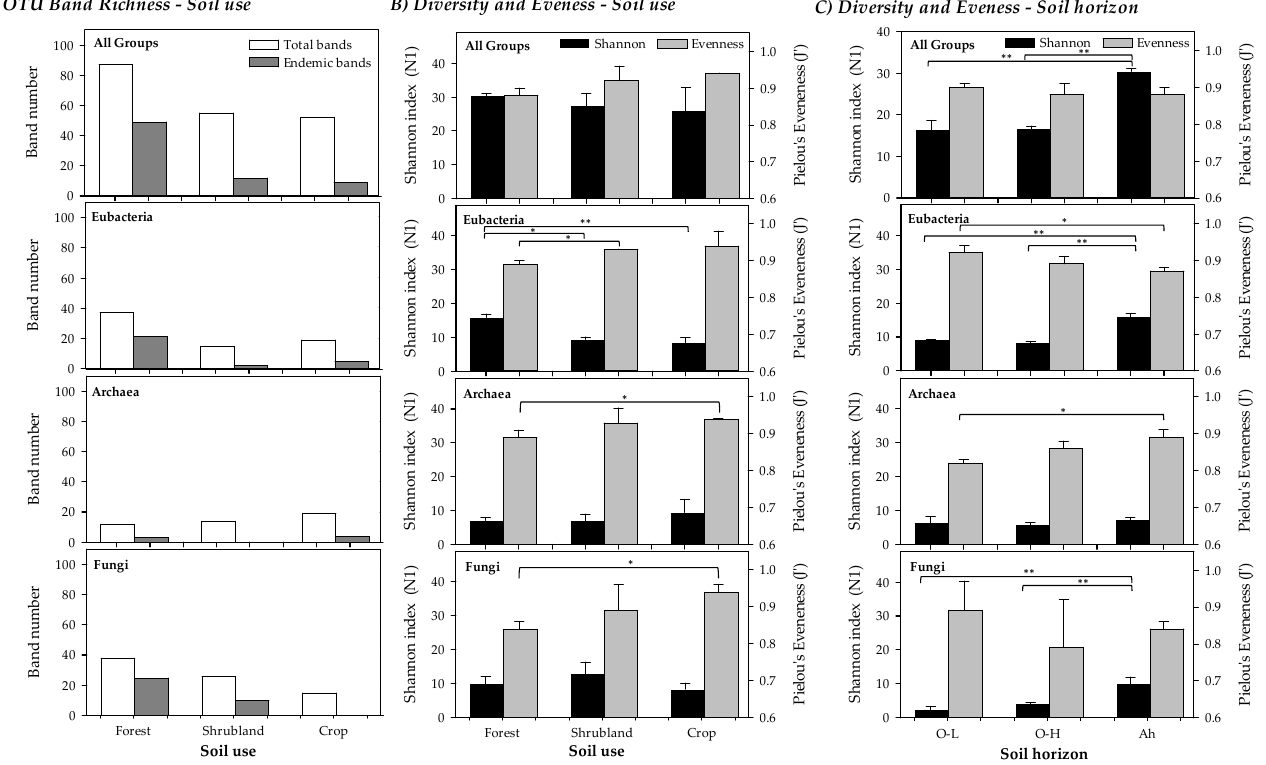
Figure 3. ( A ) Band richness, ( B ) Shannon Diversity (N1) and Pielou’s Evenness (J’) indices measuring microbial diversity (Total, Bacteria, Archaea and ectomycorrhizal Fungi) for the different soil uses (forest, shrubland and crops) in the A- horizon. Statistically significant differences in Shannon Diversity (N1) and Pielou’s Evenness (J’) among soil use types are marked (* p < 0.05; ** p < 0.01). ( C ) Shannon index (N1) and Pielou’s Evenness (J’) at different soil horizons in forest soils (Total, Bacteria, Archaea and ectomycorrhizal Fungi). Statistically significant differences among soil use types are marked (* p < 0.05; ** p < 0.01).